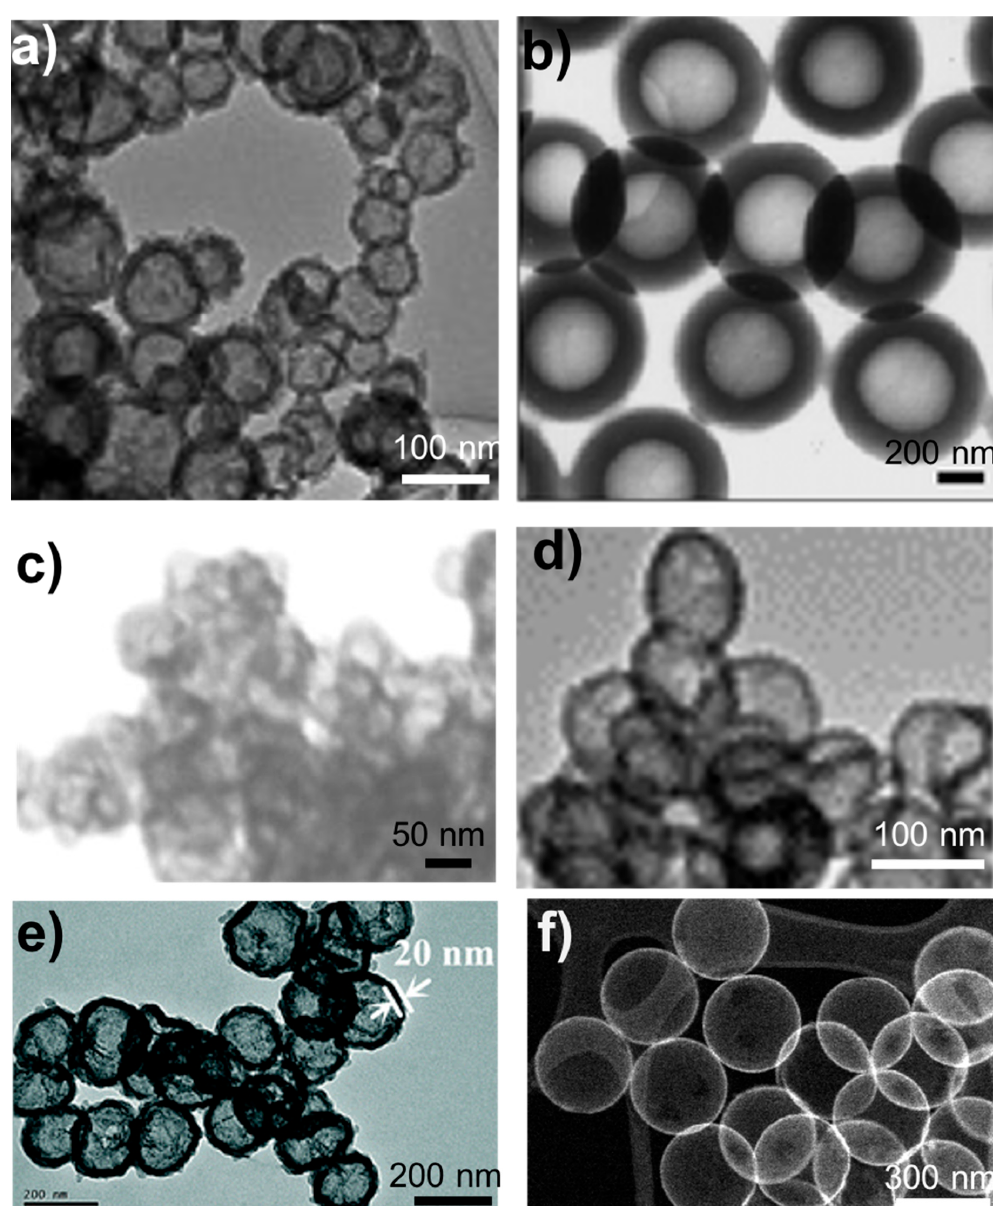
Figure 1. Schematic illustration of common strategies used for hollow silica particle (HSP) synthesis.